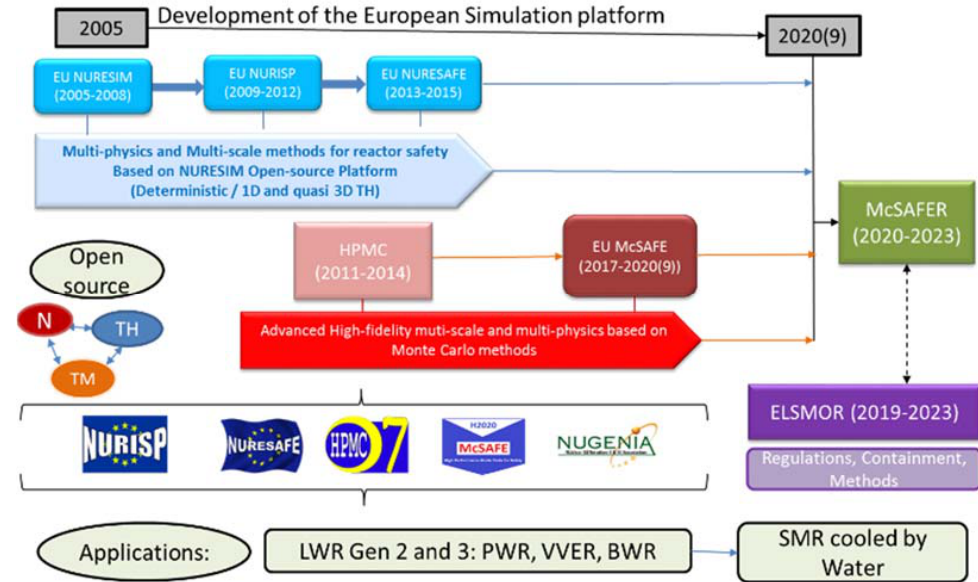
Figure 1. Roadmap for the McSAFER tools in the EU context.